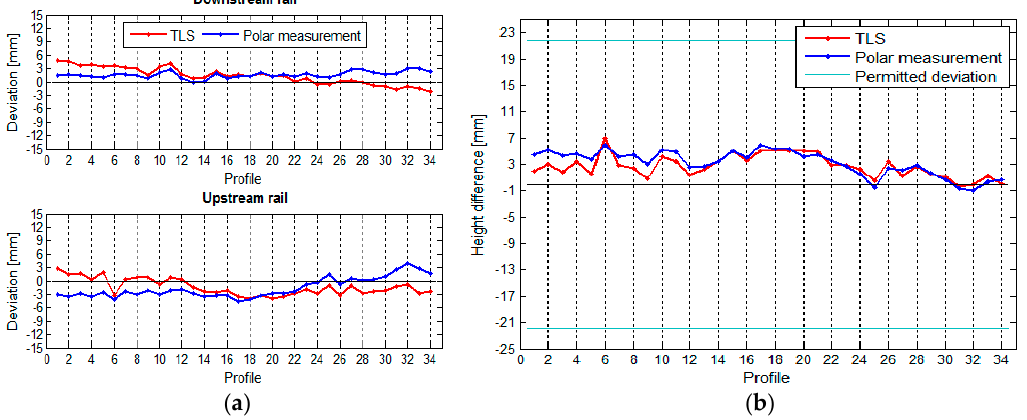
Figure 24. ( a ) Comparison of the vertical deviations and ( b ) height differences between the rails. Table 5. The comparison of horizontal and vertical parameters of the crane rail geometry, performed by both measurement methods. Comparison of the Comparison of the Comparison of the Span Downstream Rail Deviation Upstream Rail Deviation and Vertical Differences